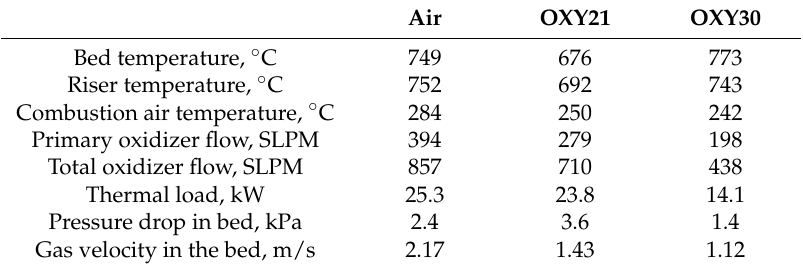
Average working parameters of the circulating fluidized bed (CFB) during different